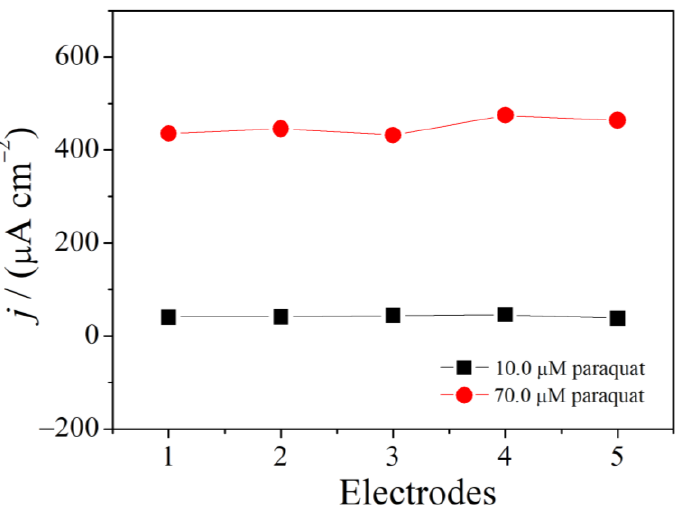
Figure 5. Analytical signal obtained in the inter-electrode repeatability study for the determination of paraquat (at two different concentrations) in 0.1 mol L −1 Na 2 SO 4 solution using SWV and the proposed paper-based silver sensor.